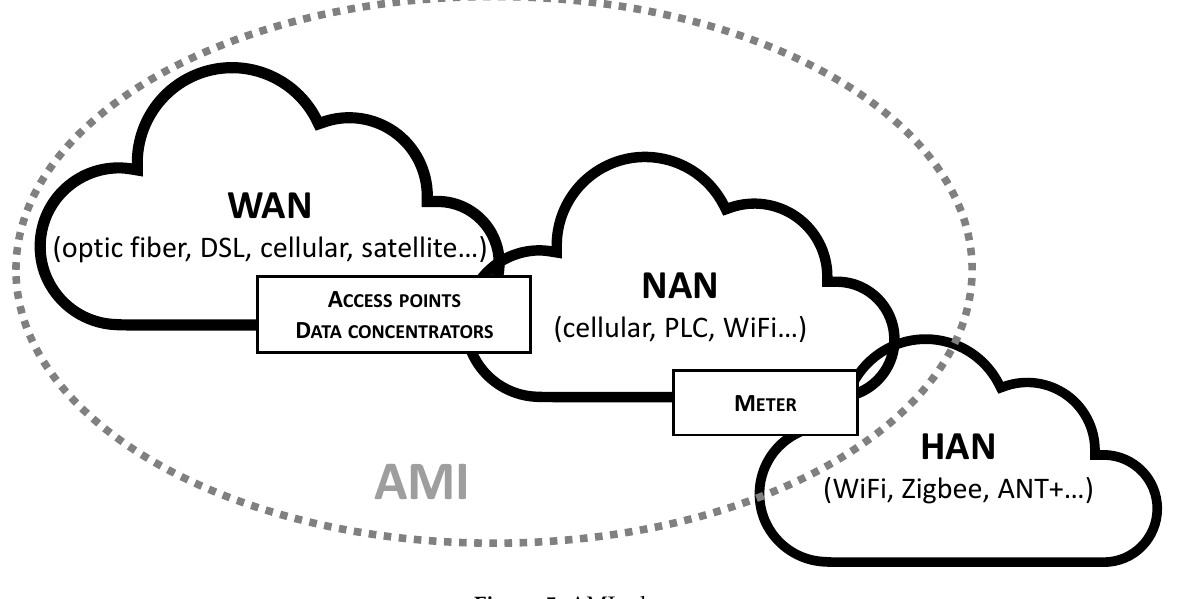
Figure 5. AMI Figure 5. AMI scheme.